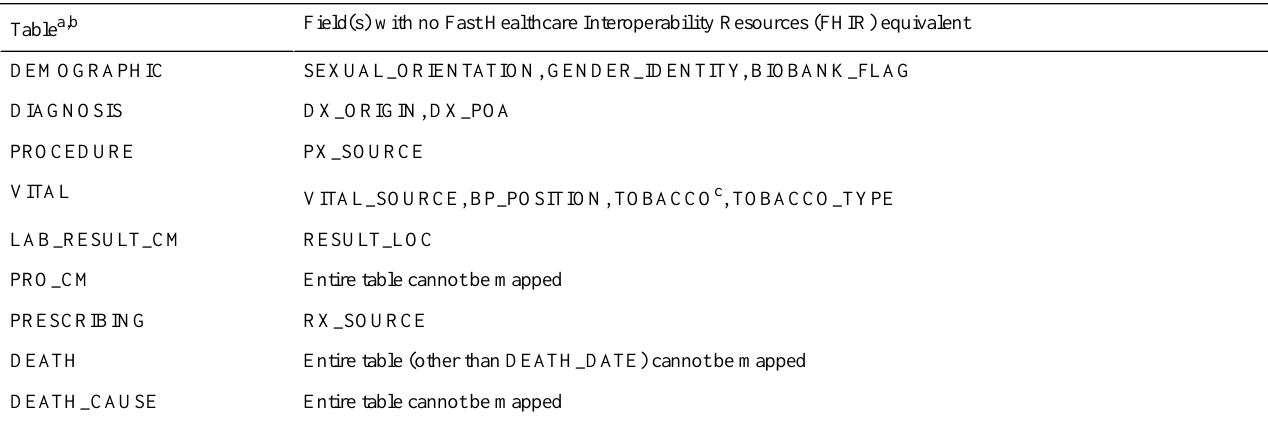
Table 3. Patient-Centered Outcomes Research Network 4.1 data with no (noncustom) exact Fast Healthcare Interoperability Resources equivalent. Field(s) with no Fast Healthcare Interoperability Resources (FHIR) equivalentTable a,b SEXUAL_ORIENTATION, GENDER_IDENTITY, BIOBANK_FLAGDEMOGRAPHIC